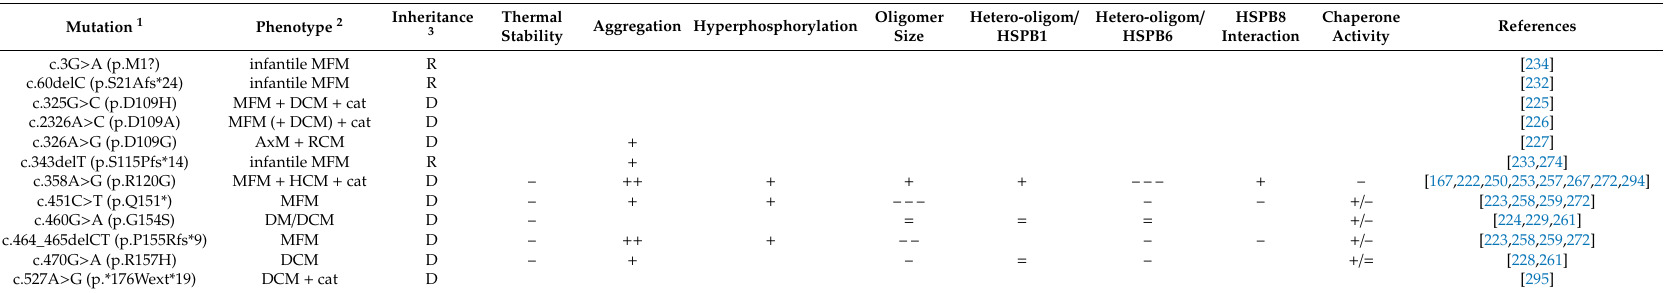
Table 5. α B-crystallin ( CRYAB ) mutations reported to cause muscle or heart disease, and functional